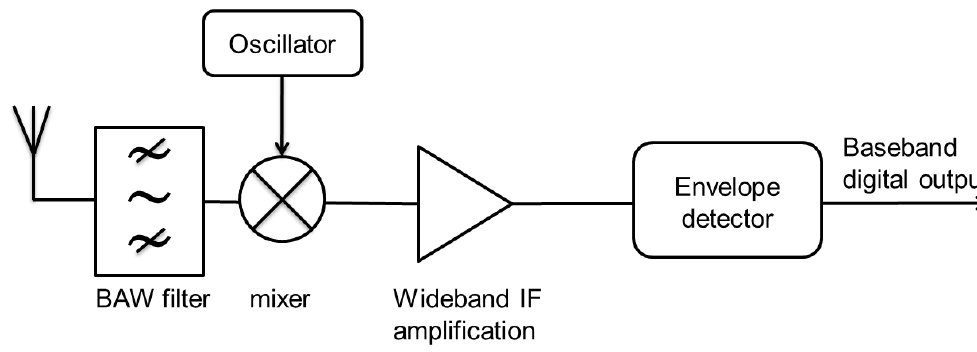
Figure 15. An example of heterodyne WuRx